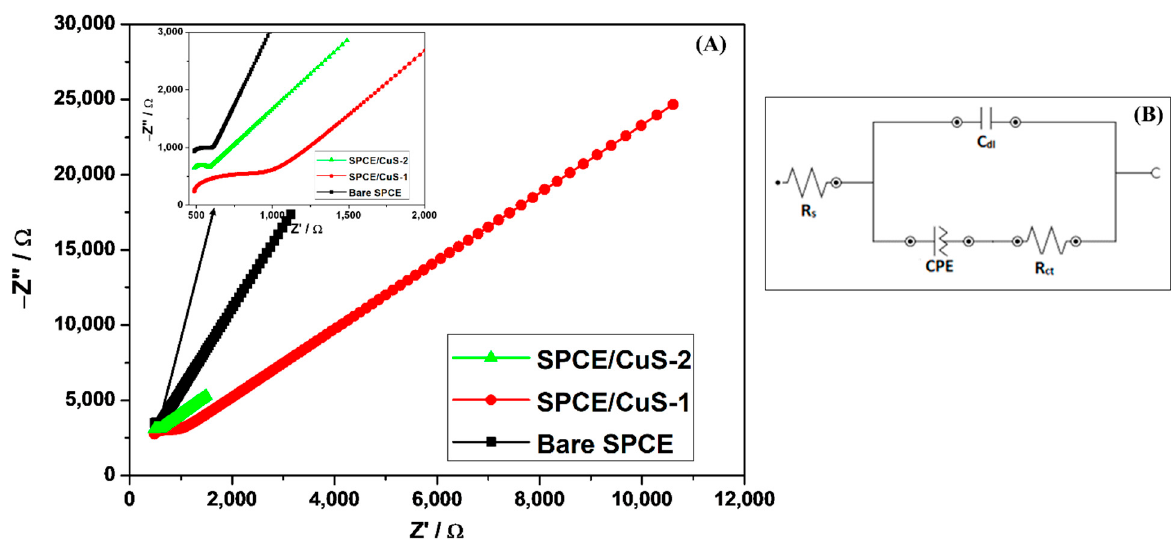
Figure 5. ( A ) Nyquist plots of (i) bare SPCE and (ii) SPCE/CuS-1 and (iii) SPCE/CuS-2 (insert: Nyquist plot highlighting the bare and Cu x S y -modified SPCE) and ( B ) Randles equivalent circuit in